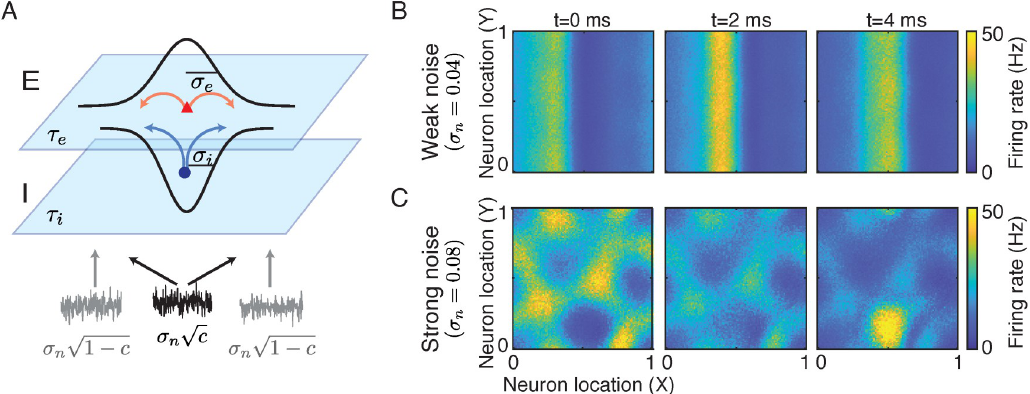
Fig 6. Two-dimensional networks with input noise. A . The input noise to each neuron consists of a correlated noise component (black) that is common for all neurons from the same population, and an independent noise component that is private to each neuron (gray). B-C . Snapshots of the firing rates of the excitatory population at three time frames for a network that generates traveling waves when there is no input noise ( τ i = 8, σ i = 0.1, same parameters as in Fig 3A). The correlation of the input noise is c = 0.5, and the amplitude is σ n = 0.04 ( B ) and σ n = 0.08 ( C ).